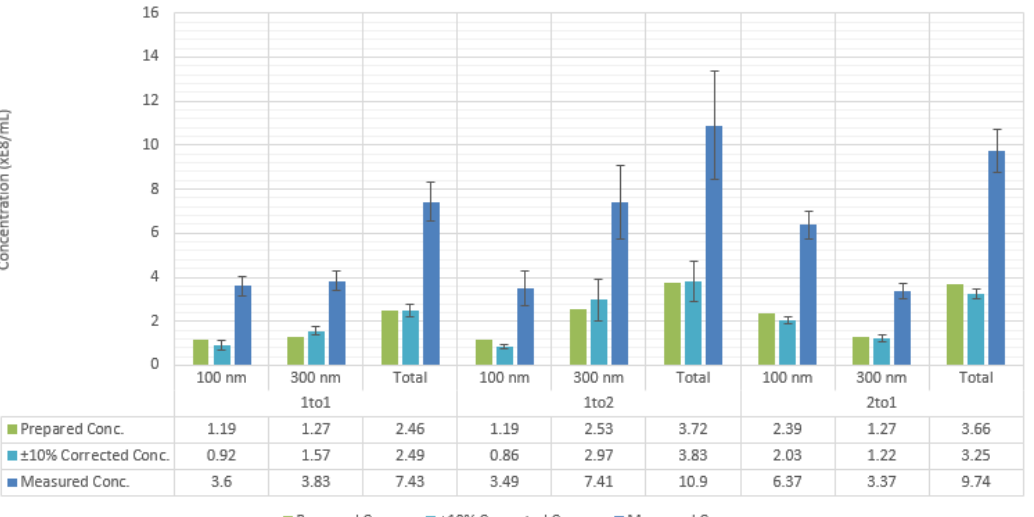
Figure 5. NTA concentration measurements for mixtures of 100 and 300 nm silica nanoparticles, composed of three different ratios of 100 to 300 nm particles. The two particle size peaks are separated from the measurement histogram then corrected separately using the correction method mentioned in this